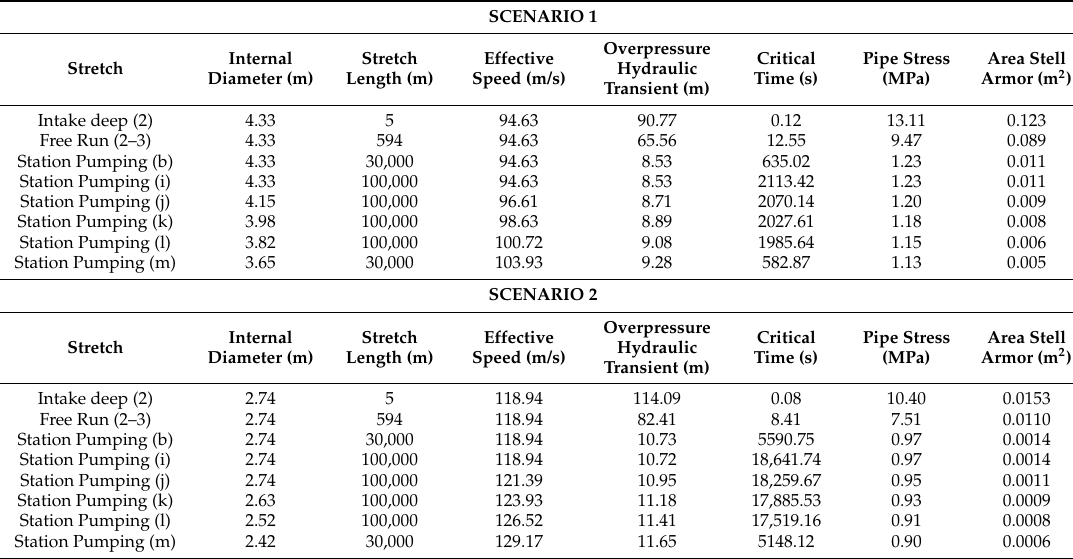
Table 10. Characterization of hydraulic transients for pipeline Parna í ba/Fortaleza-Brazil. Scenario 1 (200 L/capita/day), Scenario 2 (81 L/capita/day).